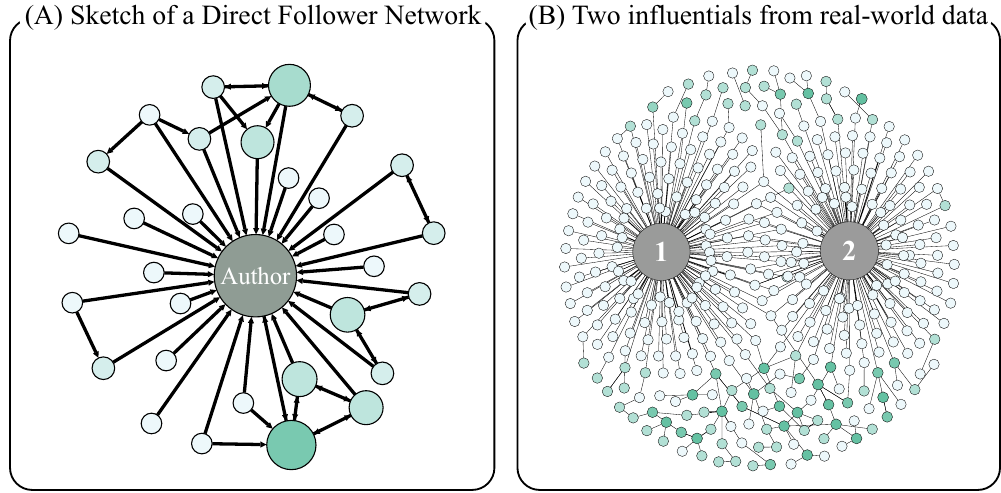
Figure 1. An illustration of Direct Follower Networks. ( A ) An influential user lies at the center of a DFN, and every other user follows him. The influential is mainly an author of popular tweets. All the followers of the influential and all the links among these followers are included in the DFN. ( B ) We show the structure of DFNs retrieved from Sina Weibo. A tweet is passed on from one influential to another. The overlap of the two DFNs is the bridge for tweet spreading. We sample the original data of the two DFNs for a better illustration. Nonetheless, the main structure has been retained.